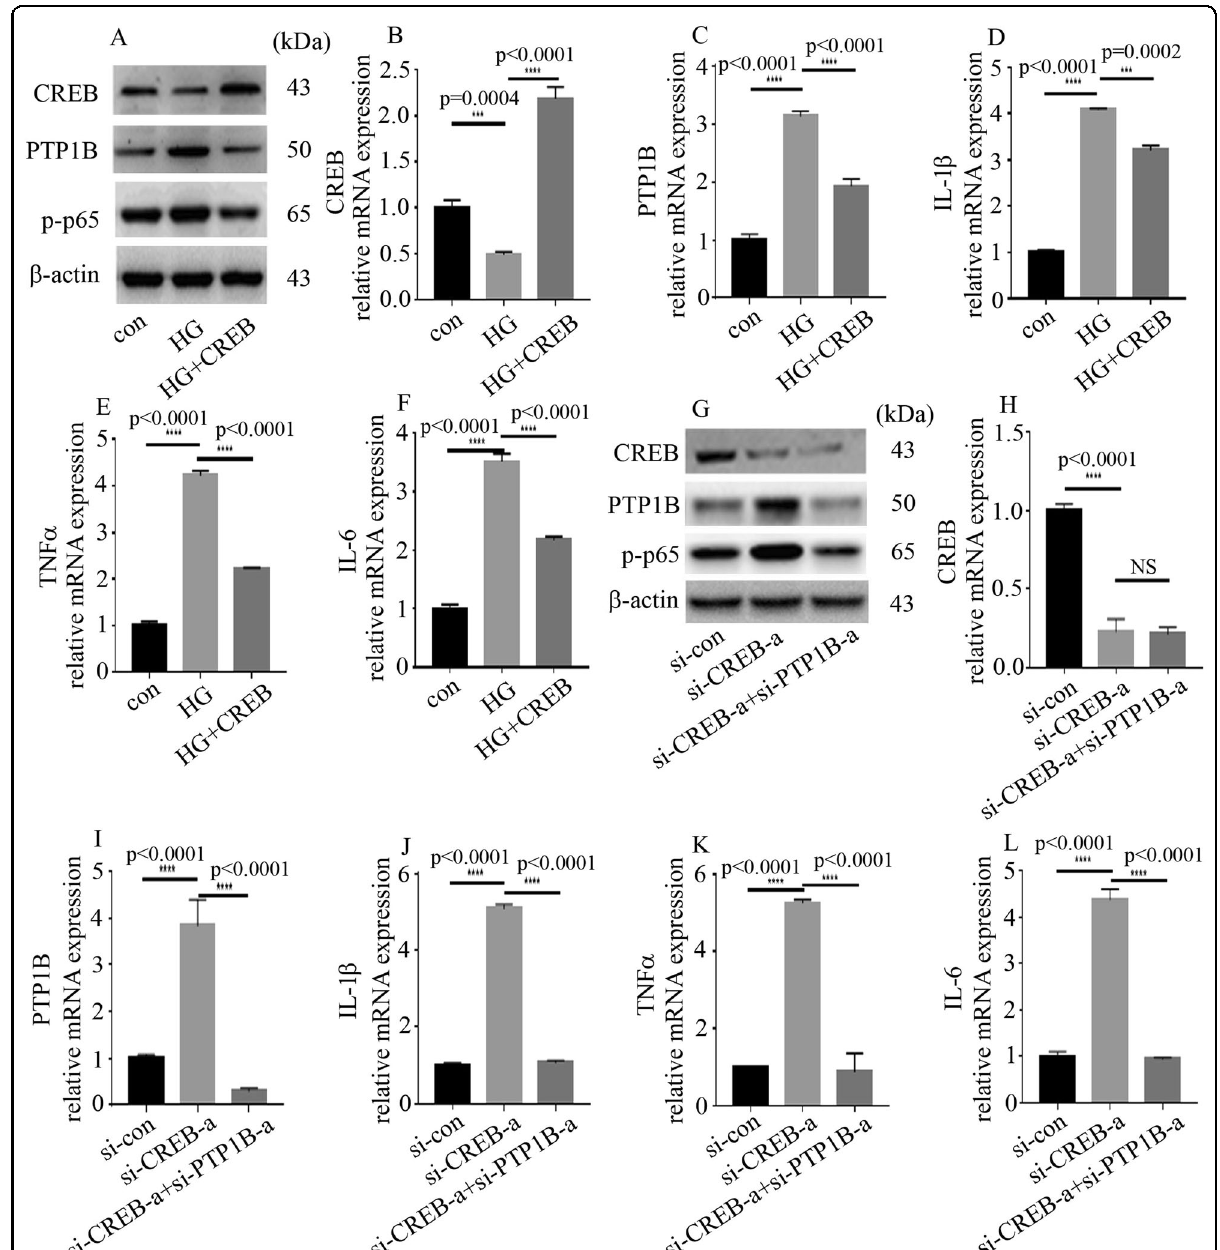
Fig. 3 CREB participates in high glucose-induced p65 phosphorylation and in fl ammatory factor levels via negative regulation of PTP1B expression in endothelial cells. A Western blot analysis of CREB, PTP1B and p-p65 levels in HUVECs. B – F qPCR analysis of mRNA expression of CREB, PTP1B, IL-1 β , TNF α and IL-6. G western blot analysis of CREB, PTP1B and p-p65 levels in HUVECs. H – L qPCR analysis of mRNA expression of CREB, PTP1B, IL-1 β , TNF α and IL-6. (* p < 0.05, ** p < 0.01, *** p < 0.001, **** p < 0.0001, n =